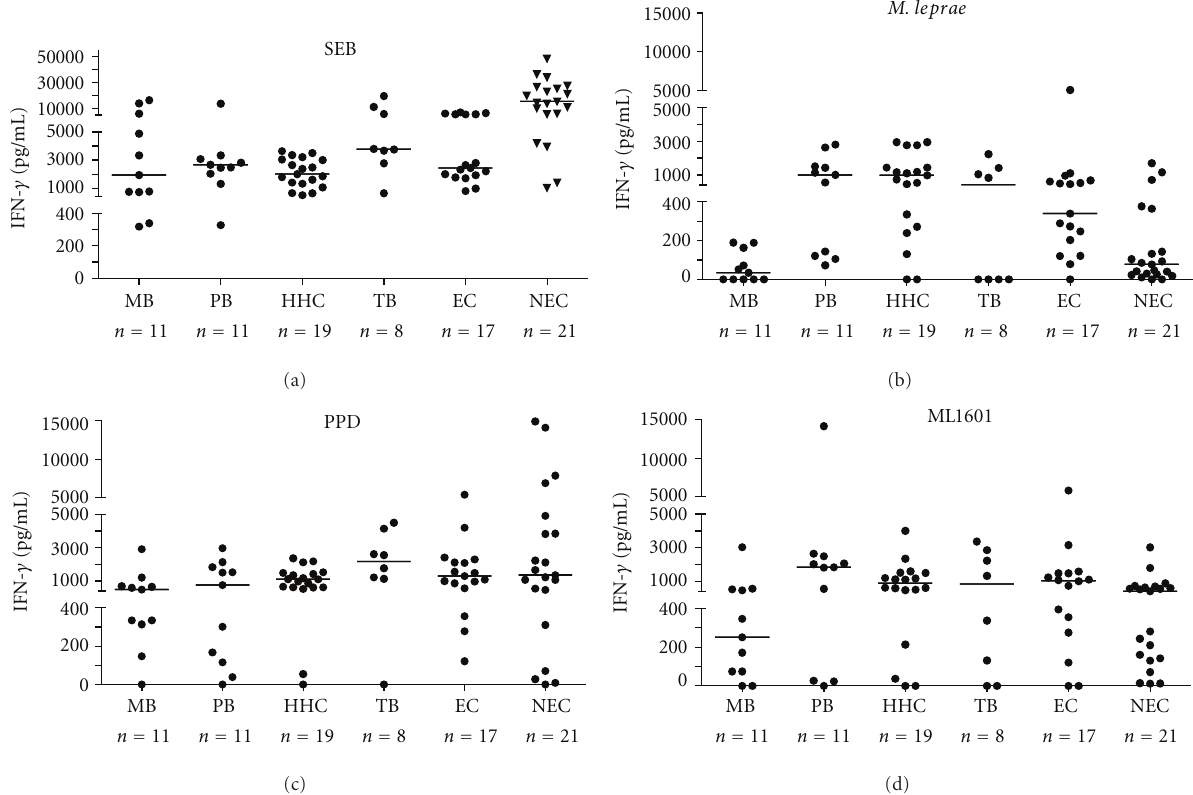
Figure 1: IFN- γ production by PBMC induced by SEB (a), PPD (b), M. leprae (c), and ML1601c recombinant protein (d) in MB ( n = 11), PB ( n = 11), HHC ( n = 19), TB ( n = 8), and EC ( n = 17) from Brazil as well as in Dutch NEC ( n = 21). For NEC, PHA was used instead of SEB. Values were corrected for background values. All background values were typically < 20pg/mL. Horizontal bars indicate median